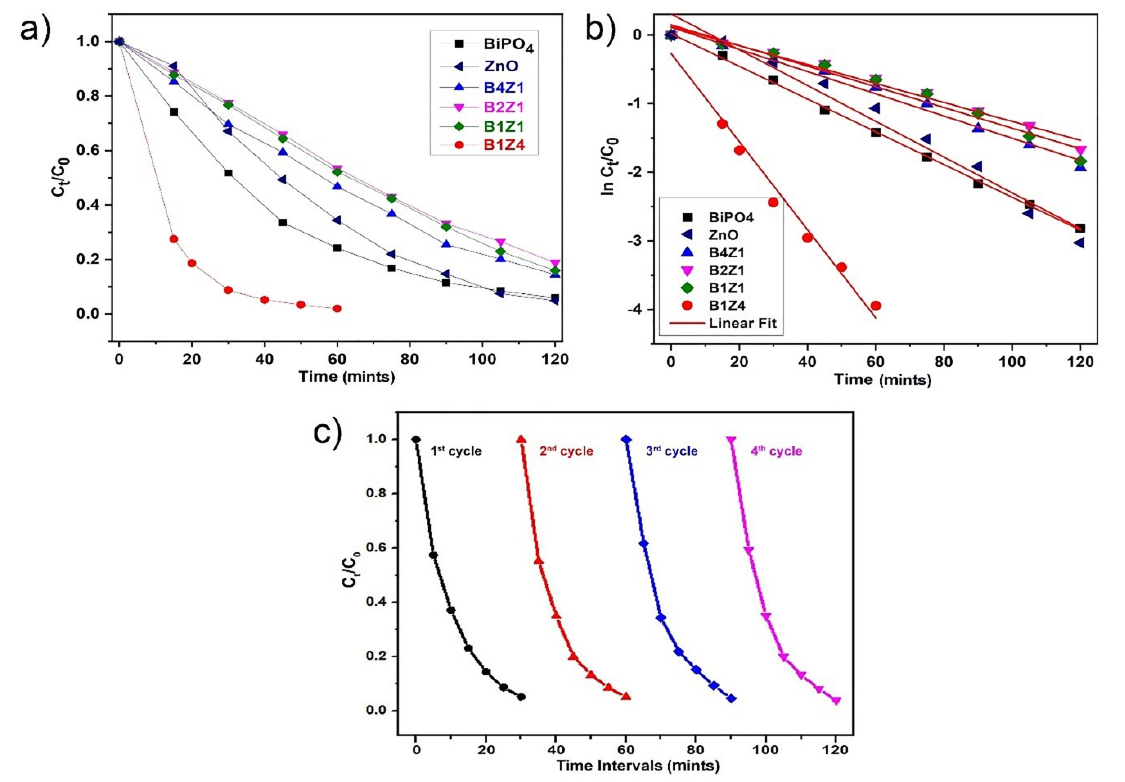
Figure 4. ( a ) Photocatalytic degradation of NPs and different concentrations of BiPO 4 and ZnO loadings NCs under UV light exposure. ( b ) Pseudo-first-order-kinetics plot for the catalytic degradation of MB dye. ( c ) Photocatalytic reusability/stability test after repetition reaction of flower-like BiPO 4 /ZnO-NCs (B1Z4-75:300; NCs-4).